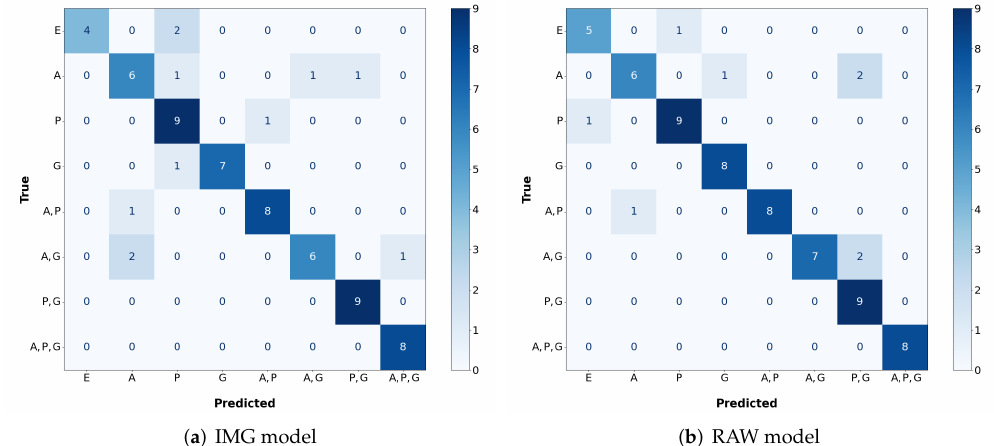
Figure 13. Confusion matrices for the best IMG and RAW models. E—Empty, A—Aluminium, P—Plastic, and